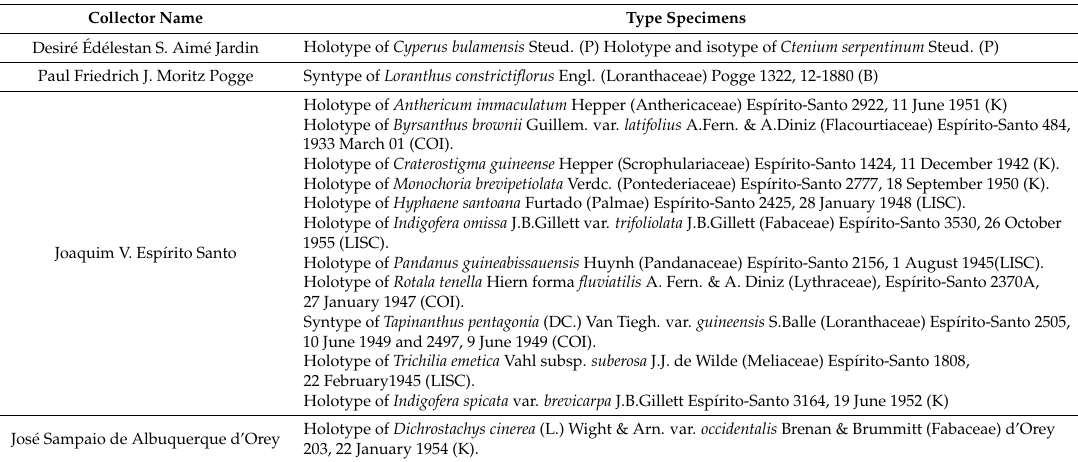
Table 1. Specimens collected in Guinea-Bissau designated as nomenclatural